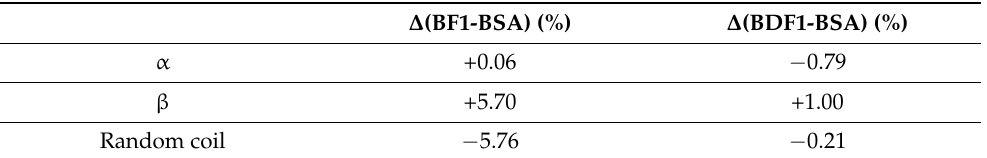
Table 1. Variations in BSA structure content (%) determined by benzofuran ligands. Please note that even though only minor changes can be detected after ligand binding, BF1 determines an increase in β -sheet more significant than BDF1.